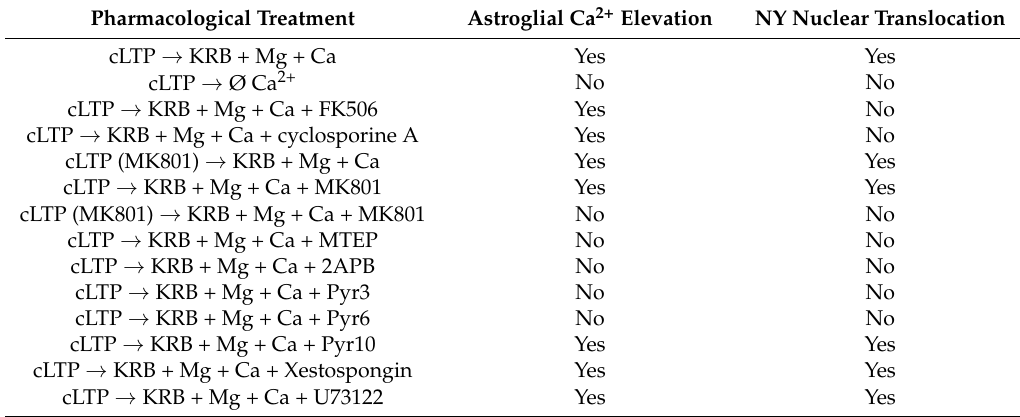
Pharmacological characterization of cLTP-induced astroglial Ca 2+ signals and NY